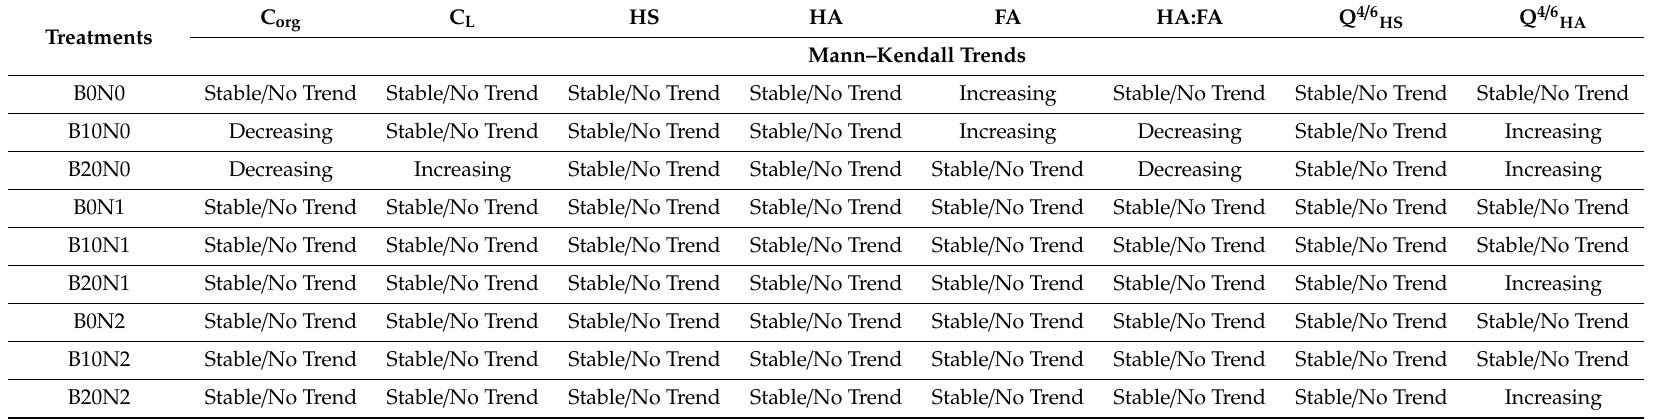
Table 4. Dynamics of soil organic matter and humus parameters according to the results of the Mann–Kendall